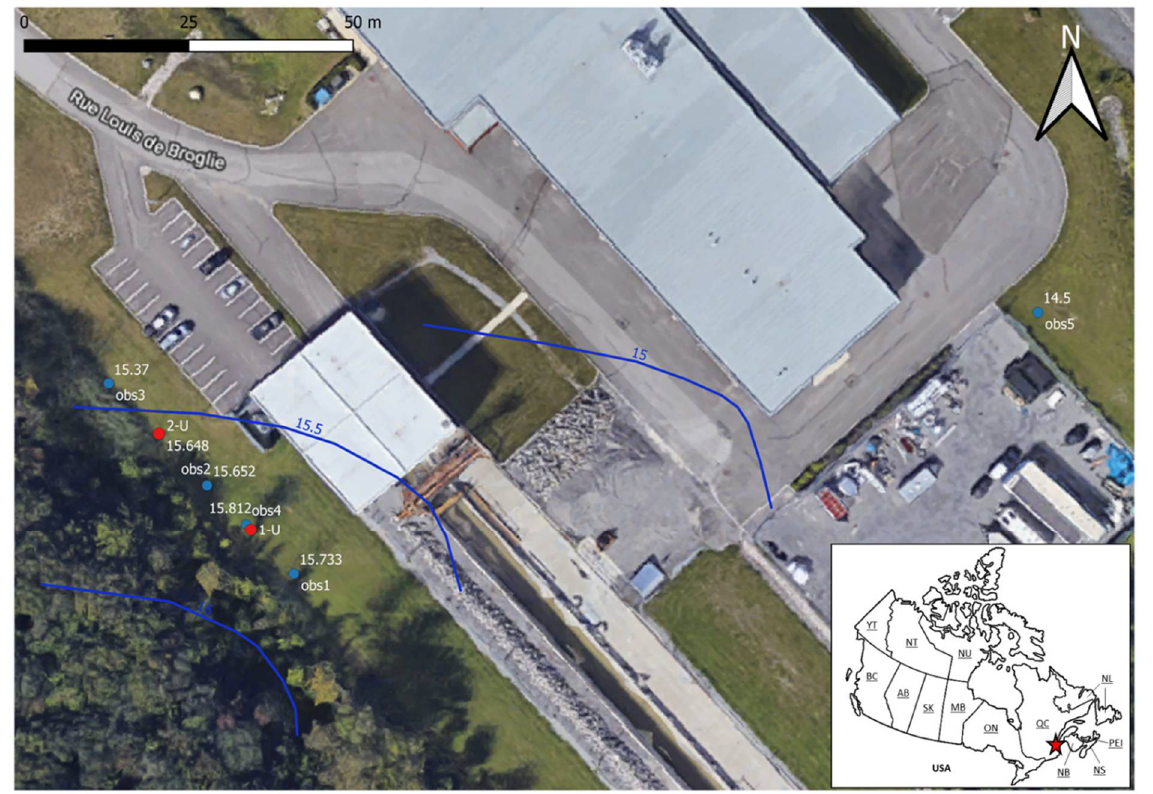
Figure 3. Orthophoto view of the study site. BHEs and observation wells are indicated by red and blue dots, respectively. Numbers indicate the water level in meters above sea level (m a.s.l.), blue lines represent the local potentiometric field.